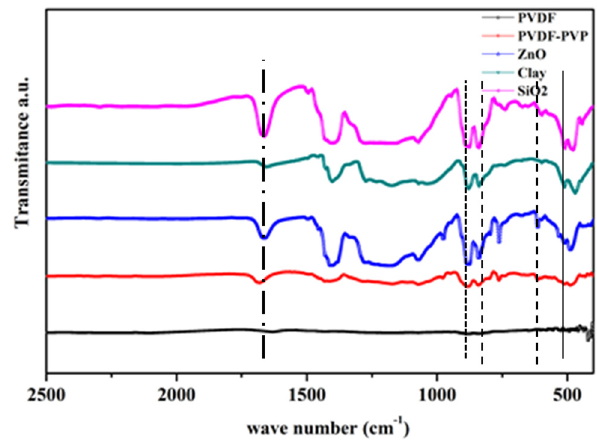
Figure 1: FTIR spectrum of PVDF GPE membranes with di ff erent fi llers ( nano - clay, ZnO, and SiO fl y ash waste ) . 2 from